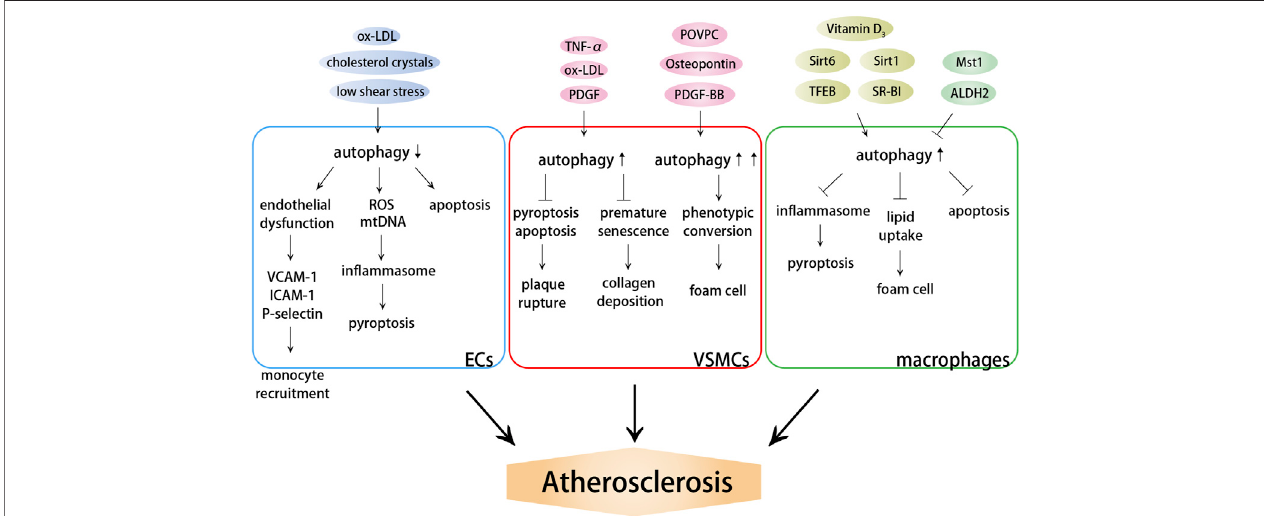
FIGURE 1 | Effects of autophagy on atherosclerosis. Autophagy dysfunction induces endothelial dysfunction and in fl ammation, promoting monocyte recruitment and cell death. Autophagy dysfunction aggravates plaque instability and promotes the formation of foam cells by in fl uencing VSMC death and phenotypic conversion. Autophagy dysfunction induces lipid accumulation, macrophage foam cell formation and cell death.